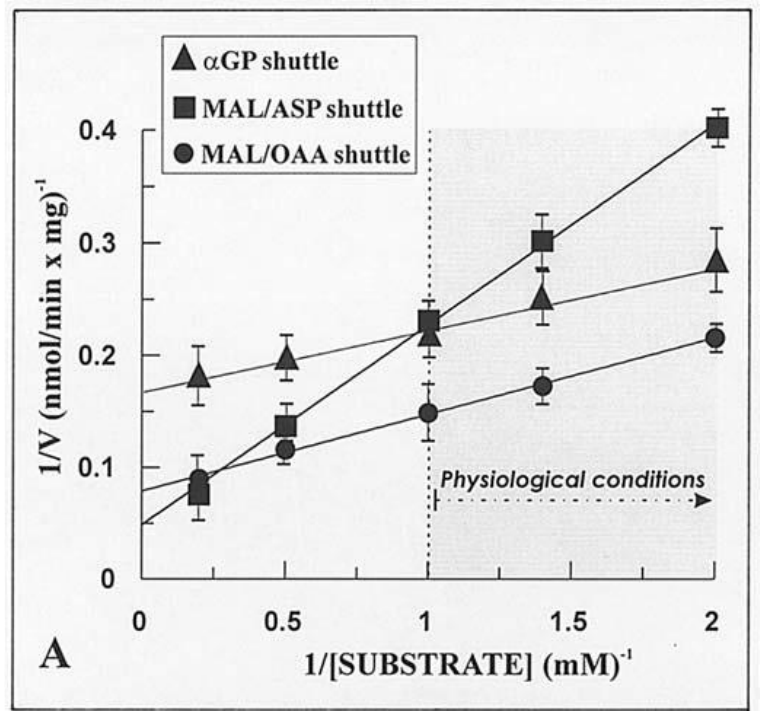
Figure 6. The dependence of the rate of NADH oxidation via the three shuttles on increasing substrate concentrations. From [12,32], with permission from Arcane Editrice, Rome and Spandidos Publications, 2021.